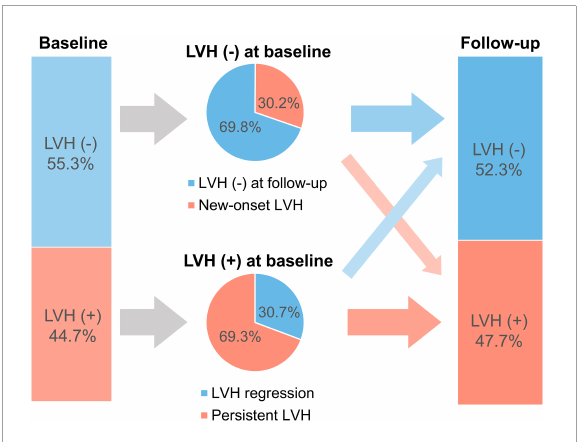
FIGURE1 Prevalence of patients with LVH at baseline and follow-up. LVH, left ventricular